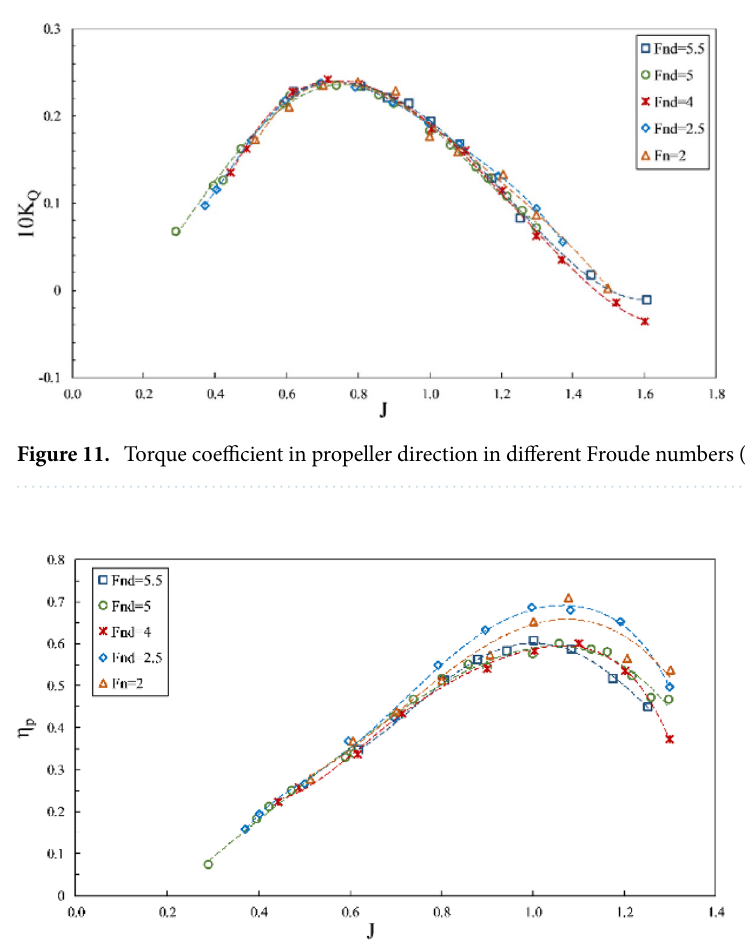
Figure 12. Efficiency in propeller direction in different Froude numbers ( I = 0.4, α = 3 ◦